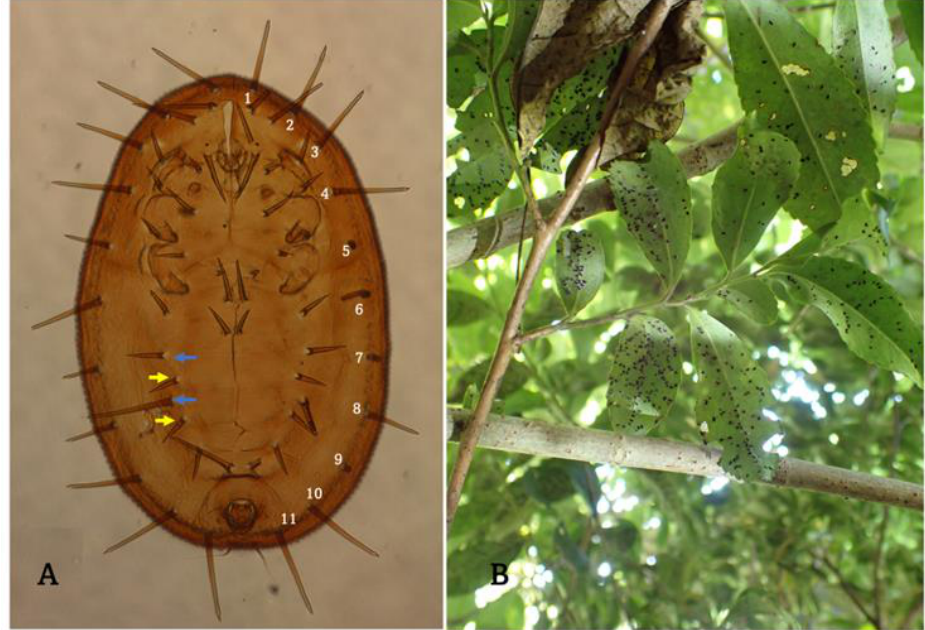
Figure 1. Tea spiny whitefly A. spiniferus morphospecies. ( A ) Slide-mounted puparia, ( B ) high infestation on Euryae japonica leaves in Ito City, Shizuoka.